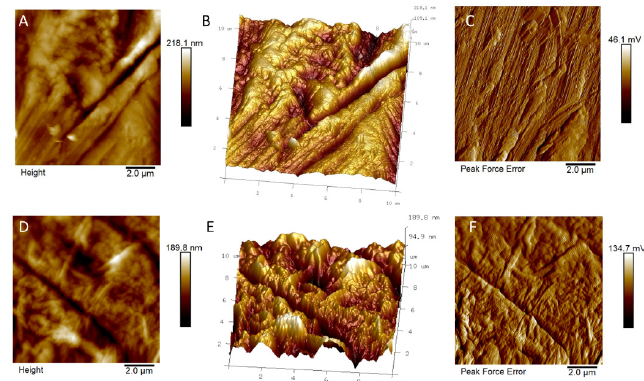
Figure 2. Atomic force microscope (AFM) images of ( A , D ) bidimensional and ( B , E ) tridimensional topography, as well as ( C , F ) peak force error of control (upper line) and control + graphene oxide (GO) discs (lower line).